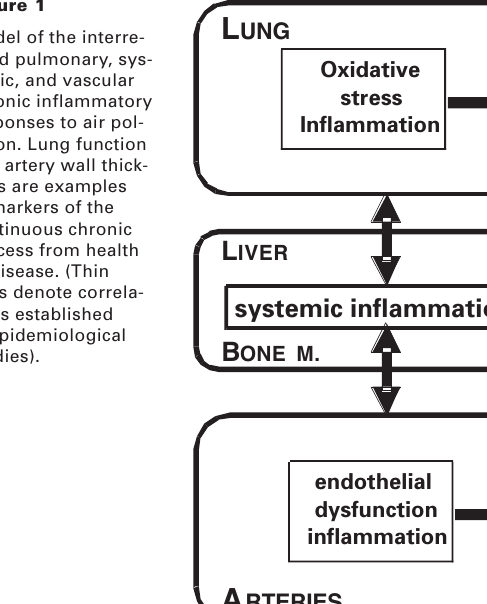
Model of the interre- lated pulmonary, sys- temic, and vascular chronic inflammatory responses to air pol- lution. Lung function and artery wall thick- ness are examples of markers of the continuous chronic process from health to disease. (Thin lines denote correla- tions established in epidemiological